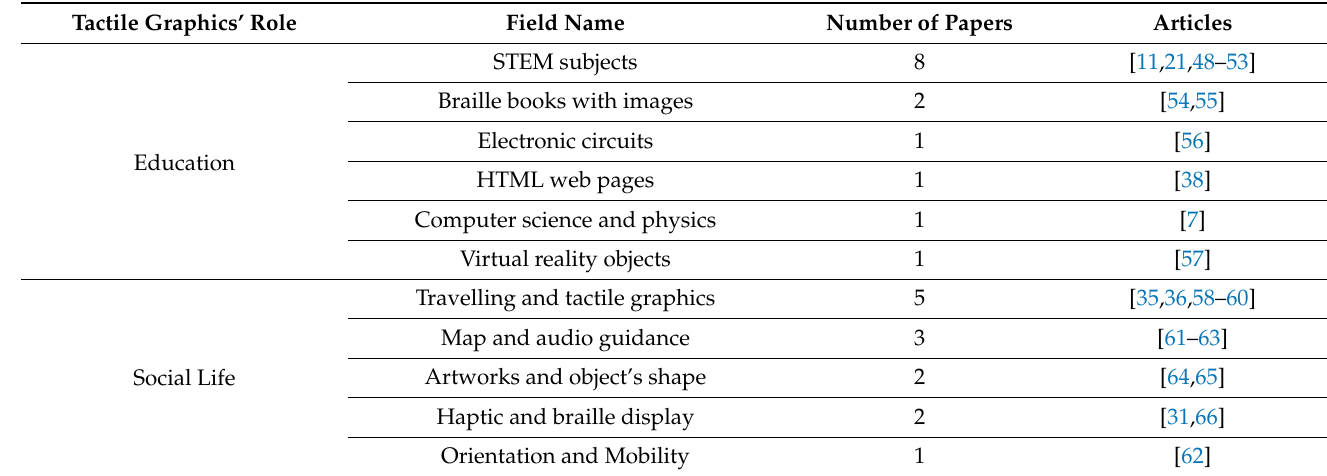
Table 3. The role of tactile graphics for use in a variety of fields.